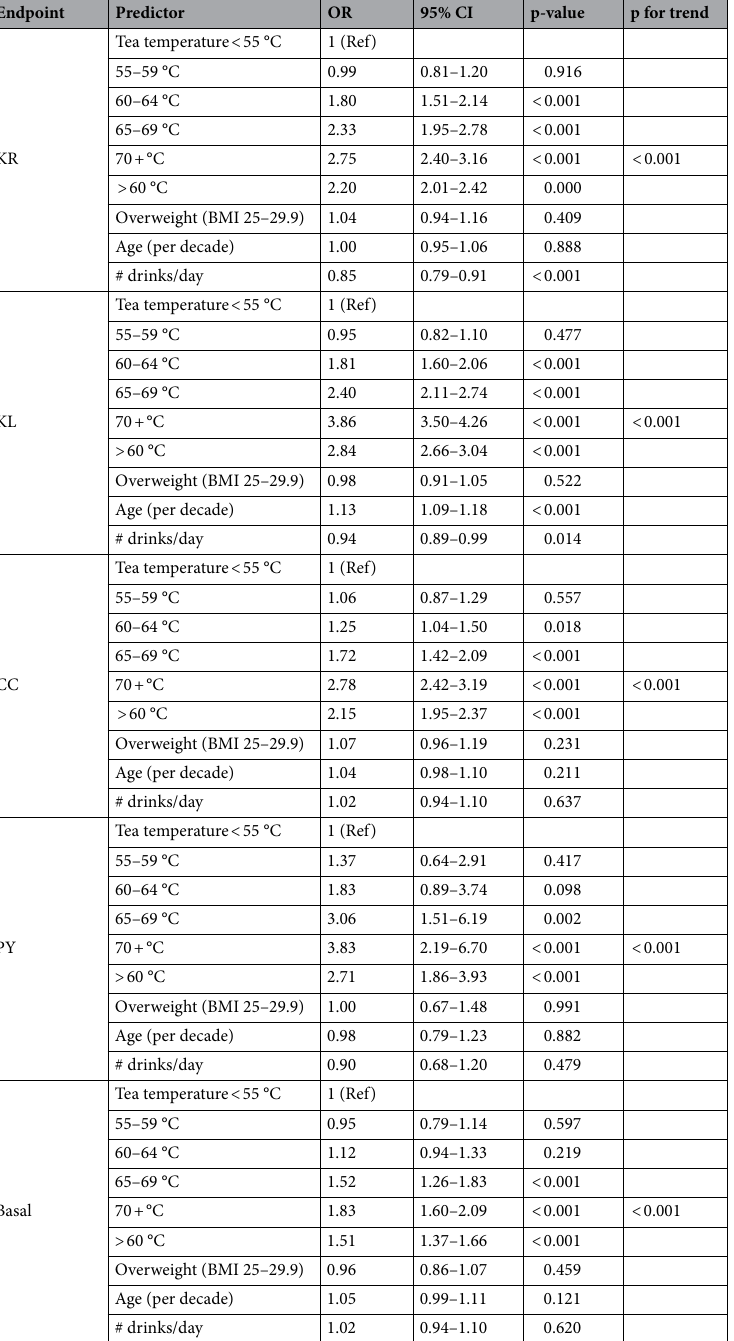
Table 2. Impact of the drinking temperature, the number of drinks/day and of demographic factors (age, BMI) on induction of nuclear anomalies reflecting acute cytotoxicity and cell proliferation (basal cells) in buccal cells. p-values from Poisson regression. KR Karyorrhexis, KL karyolysis, CC condensed chromatin, PY pyknosis, OR odds ratio, CI confidence interval. Number of participants per temperature group: < 55 °C (n = 21); 55–59 °C (n = 11); 60–64 °C (n = 15); 65–69 °C (n = 6); 70 + °C (n =